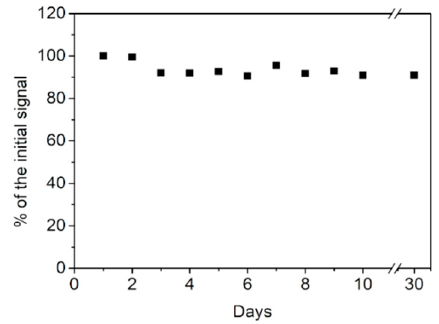
Figure 6. Long-term stability of the GCE / N-rGO-Au sensor in 100 µ M DA.